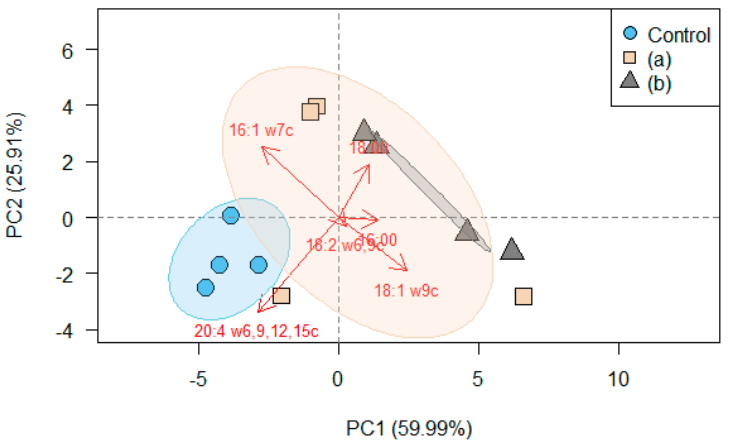
Figure 2. Biplot of principal component analysis (PCA) based on the fatty acid profiles (%) of Allonychiurus kimi (Lee) adults after 28 d of exposure to glyphosate at concentrations of 0.0 (control), 37.1 (a), and 370.5 (b) mg kg − 1 with a 95% confidence ellipse. The arrows indicate the direction and magnitude at which each variable contributes to the variation between the treatments.